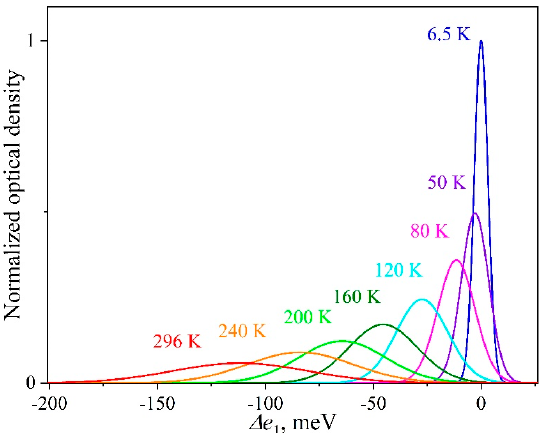
Figure 6. Visualization of the temperature behavior of the exciton absorption peak corresponding to individual nanocrystal in the ensemble. For illustrative purposes, the optical density is normalized to the maximum value for a component at 6.5 K.